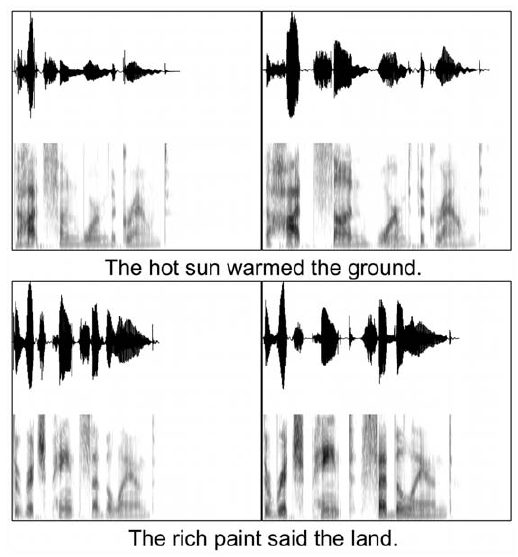
Figure 1. Waveforms and spectrograms of one meaningful sentence (top panels) and one anomalous sentences (bottom panels), each produced in both conversational (left panels) and clear (right panels) speaking styles. Each panel display